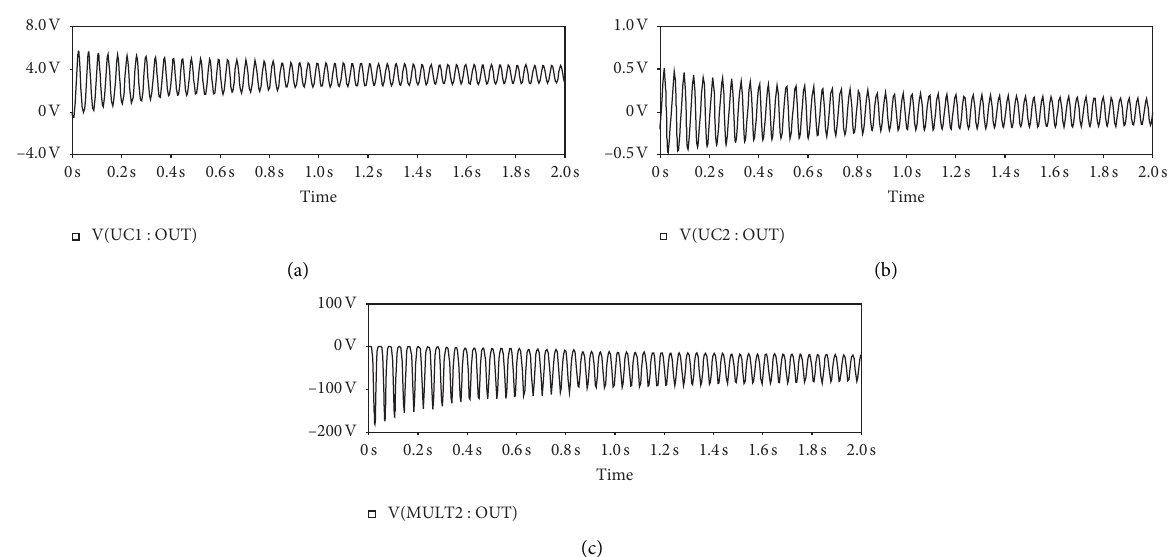
, (b) amplifier with capacitor C 1 � 12V , R � 5 K Ω ,R cc 4